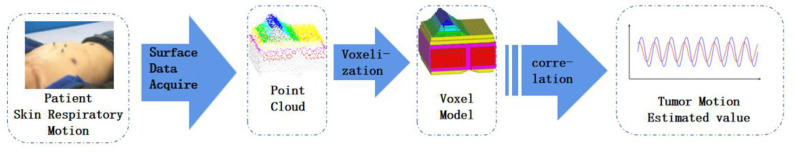
Flowchart of the respiration tracking system.